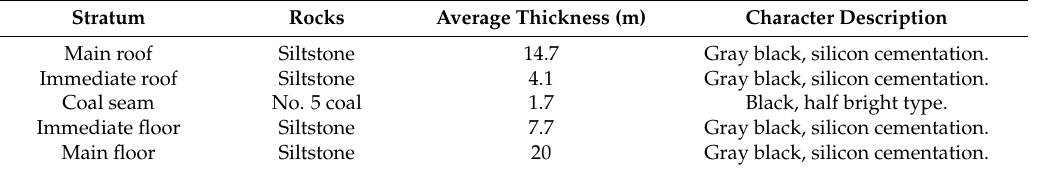
Table 1. Geological characteristics of the overlaying rock strata and the coal